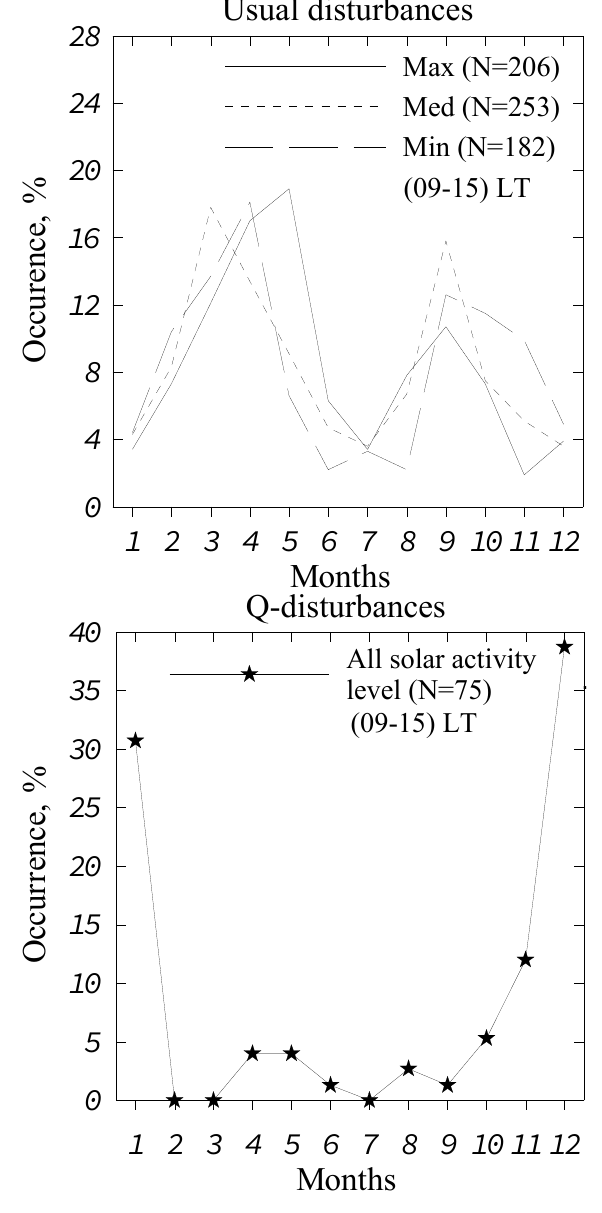
Fig. 1. Seasonal variations of the occurrence for the usual and Q- disturbances in the daytime LT sector. Due to the insufficient num- ber of daytime negative Q-disturbances, all solar activity levels are put together; total number of events is given in parentheses.